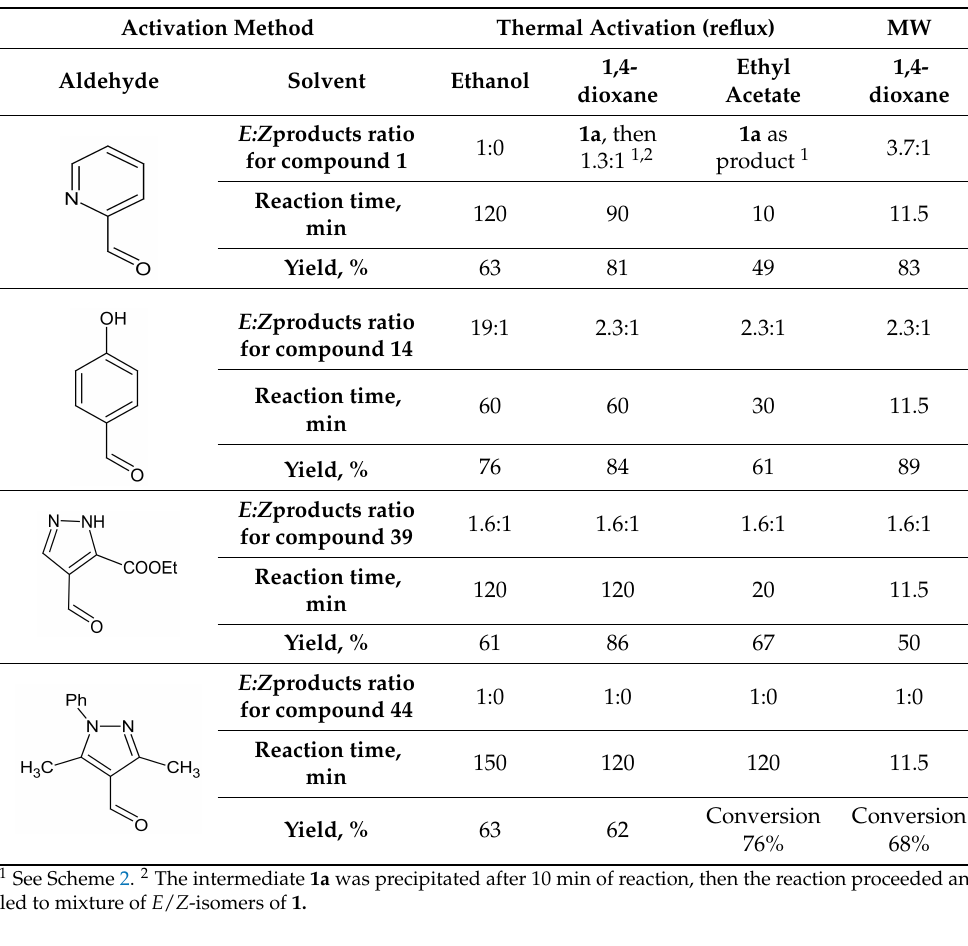
Table 3. Influence of the reaction conditions on the ratio of